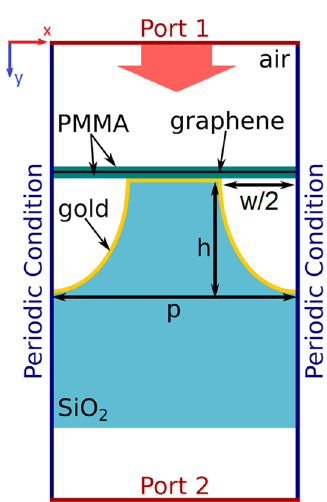
Figure 2. The graphene/gold/patterned SiO 2 metasurface FEM model under THz irradiation in COMSOL.